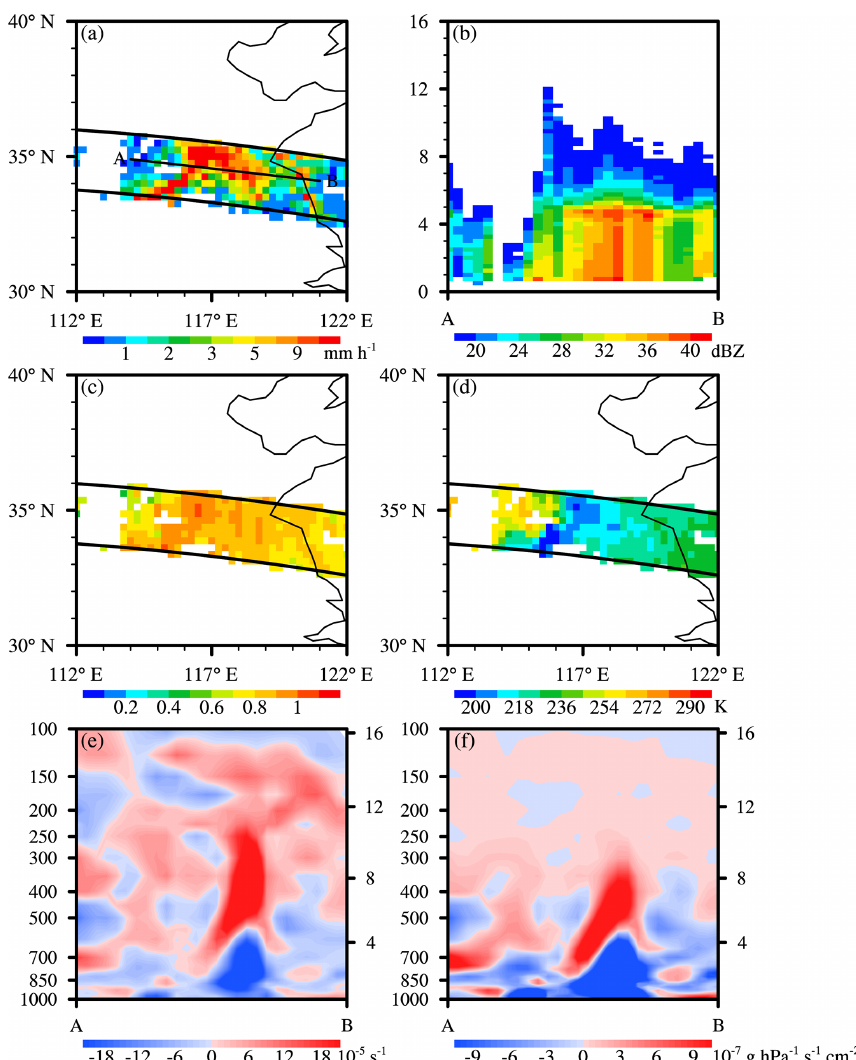
Figure 7. Case study of frontal precipitation on 3 June 2003 (orbit number 31926). (a) The near-surface rain rate; vertical cross sections of (b) the precipitation reflectivity factor, (c) RF1 and (d) TB 10 . 8 ; and vertical cross sections of (e) divergence and (f) the divergence of water vapor flux along line A–B in panel (a)